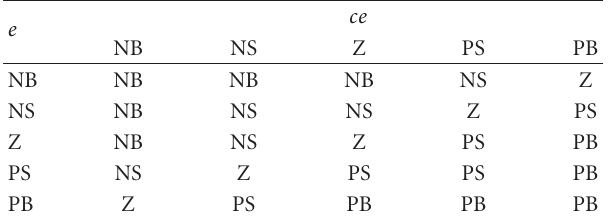
Table 4: Proposed fuzzy